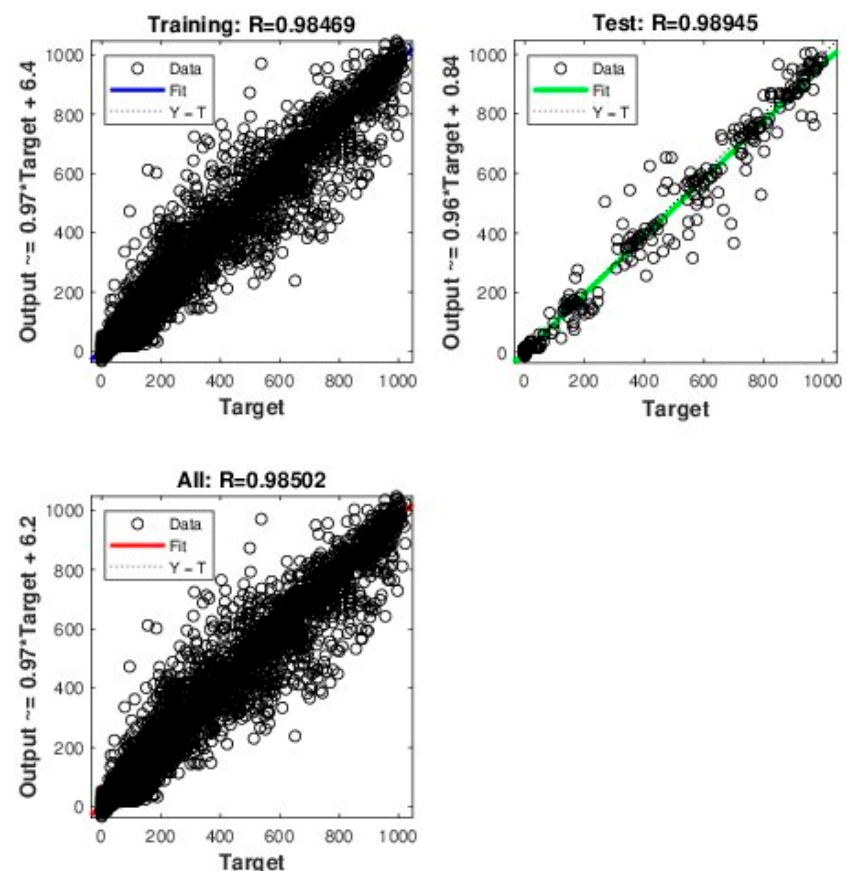
Figure 12. Regression plots of neural network (solar irradiance forecasting case).